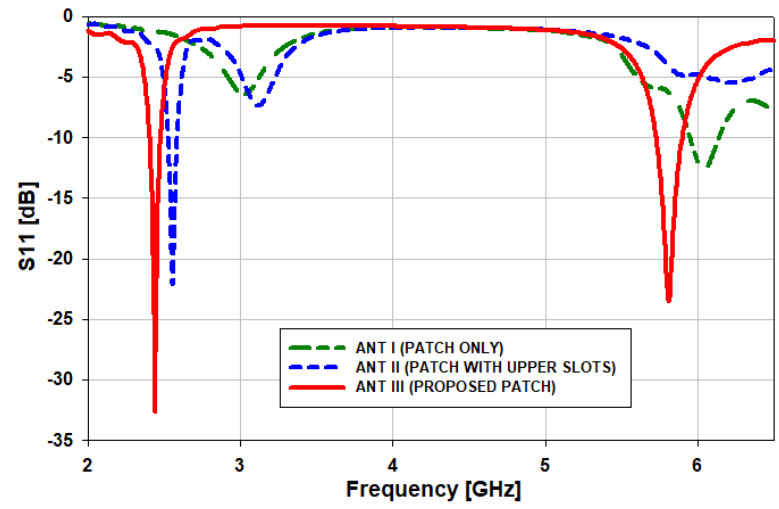
Figure 4. S 11 comparison of the various antenna designs.